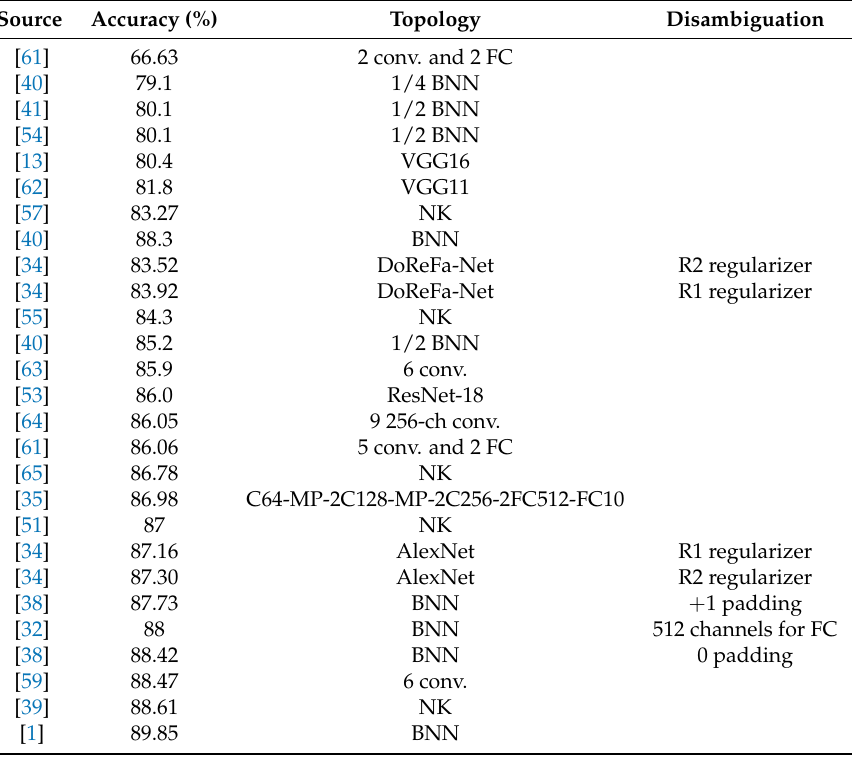
Table 9. BNN accuracies on the CIAFR-10